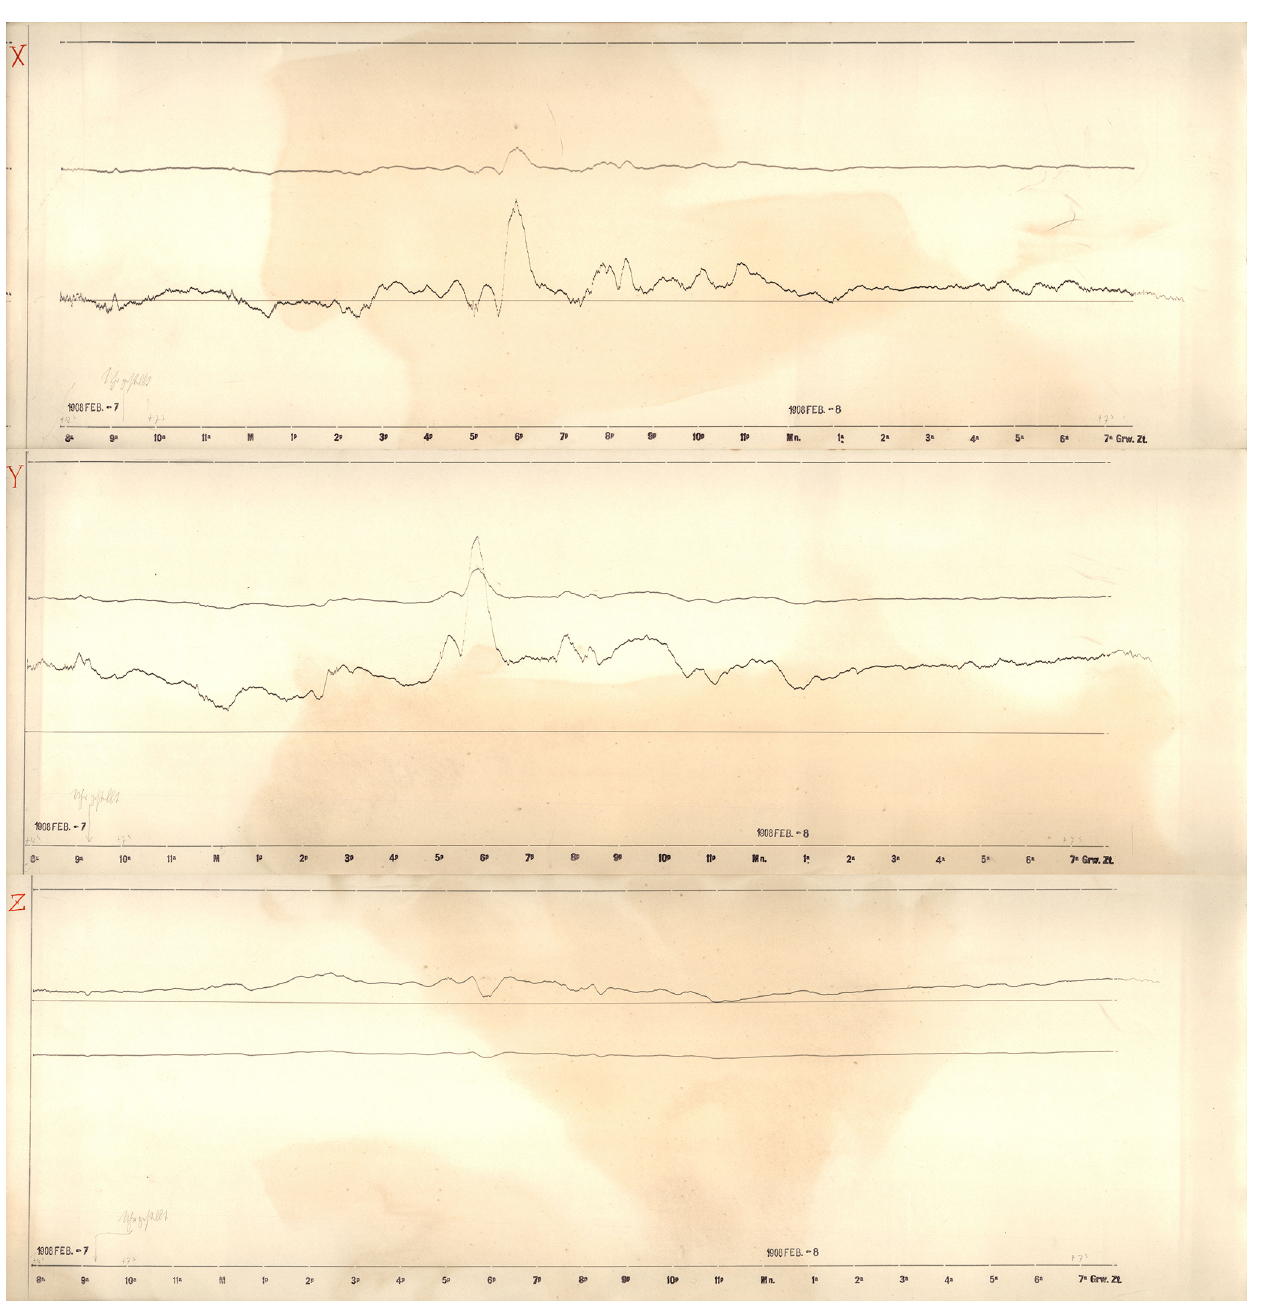
Figure 8. Seddin Observatory photographic recordings of the north (top), east (middle) and vertical component (bottom) of the time interval of 7 February 1908 at 08:00 till 8 February 1908 at 08:00 (Greenwich civil mean time). Source: Helmholtz Centre Potsdam –